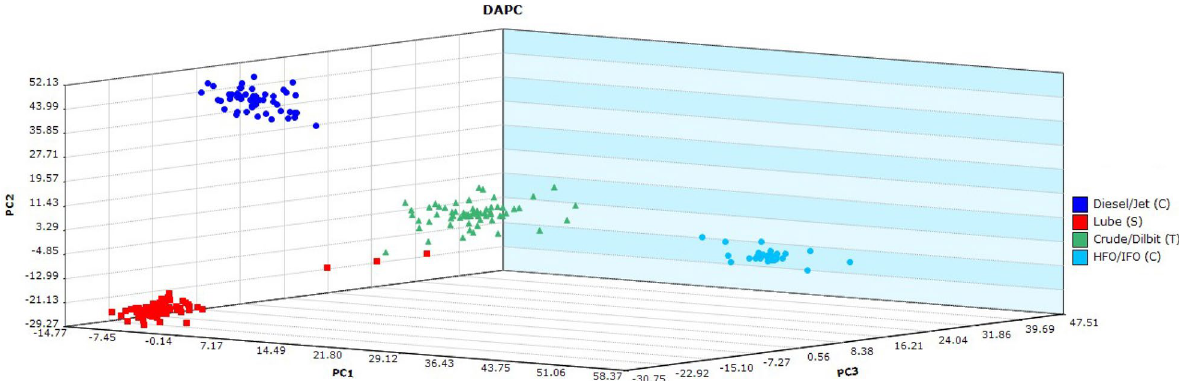
Fig. 6 Discriminant analysis of principal components of the reference oils